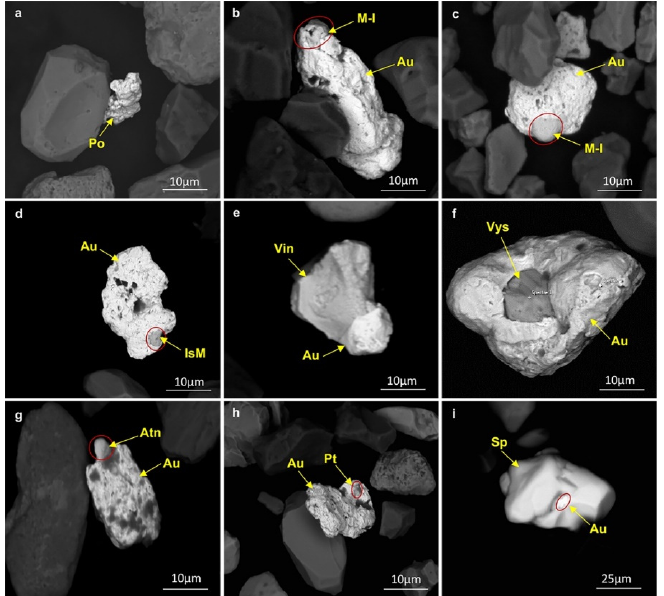
Figure 15. A selection of backscatter electron (BSE) images showing PGMs and Au association. ( a ) An Au-rich (46.65 wt%) potarite; ( b , c ) Mertieite-I (M-I; Pd 11 (Sb,As) 4 ) partly encapsulated in gold; ( d ) Isomertieite (IsM; Pd 11 Sb 2 As 2 ) as an inclusion in a gold particle; ( e ) A vincentite (Vin; (Pd,Pt) 3 (As,Sb,Te)) attached to a gold grain; ( f ) Vysotskite (Vys; (Pd,Ni)S) enclosed by a gold aggregate; ( g ) An atheneite (Atn; (Pd,Hg) 3 As) attached to a gold grain with silicate inclusions; ( h ) Platinum (Pt) inclusion in a gold grain; and ( i ) Gold precipitation/nucleation on the surface of a sperrylite (Sp; PtAs 2